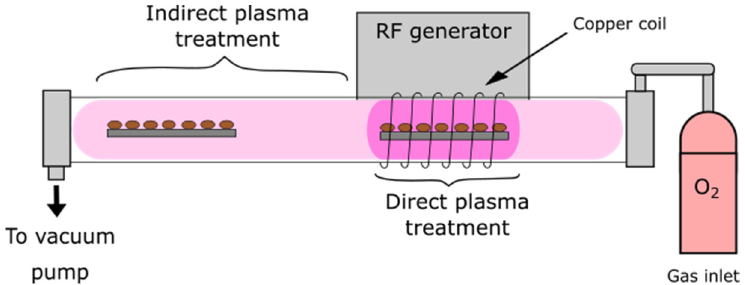
Figure 4. A schematic representation of the plasma system used in the treatment of wheat seeds.